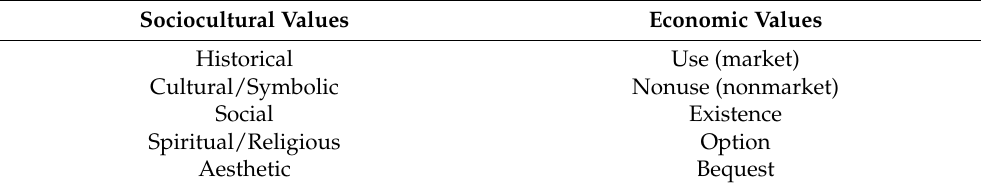
Table 1. Provisional value typologies suggested by the Getty Conservation Institute for consideration in heritage conservation planning and